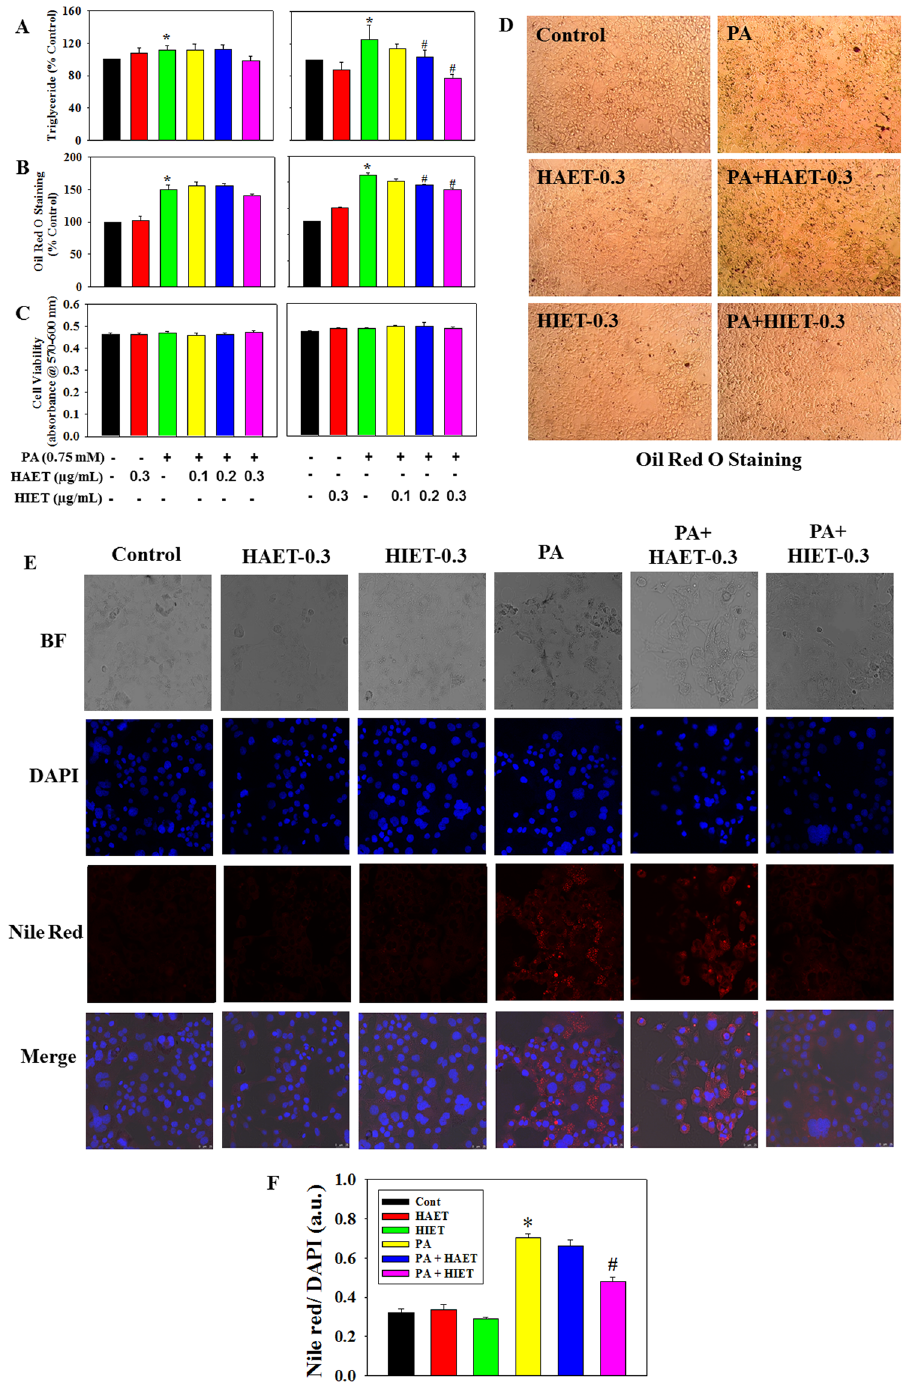
Figure 1. Effect of the different extracts of Tungrymbai, HAET (hydro-alcoholic, 70% ethanol) and HIET (hexane-isopropanol, 2:1) on intracellular lipid accumulation in palmitate (PA)-treated hepatocytes. ( A ) triglyceride content; ( B ) levels of Oil Red O staining; ( C ) cell viability; ( D ) representative photomicrographs of Oil Red O staining (10 × ); ( E ) representative photomicrographs of Nile Red and DAPI staining (40 × ); and ( F ) quantification of Nile Red/DAPI staining. Cells were pre-treated with HAET or HIET (0.1, 0.2, or 0.3 µ g/mL) for 2 h followed by PA (0.75 mM) exposure for the next 20 h. Data are expressed as mean ± SE (n = 6). “ * ” Denotes the significant difference from untreated ( * p < 0.05) and “#” denotes the significant difference from PA-treated groups ( # p <